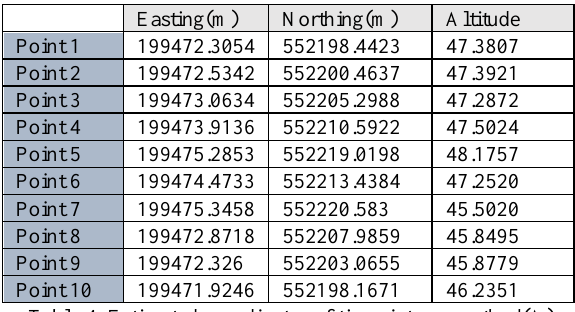
Table 4. Estimated coordinates of tie points on method(A)